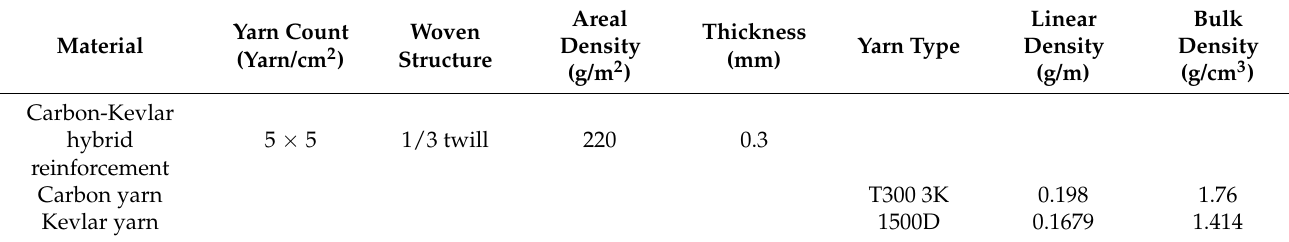
Figure 1. Tested carbon-Kevlar hybrid woven reinforcement. Table 1. Material parameters of carbon-Kevlar hybrid woven reinforcement.